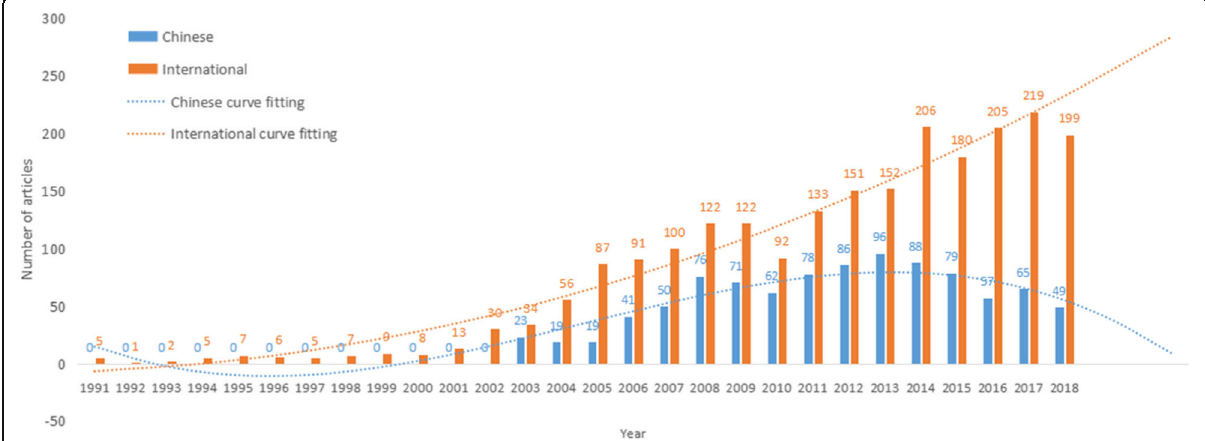
Fig. 2 Temporal distribution and trend of international and Chinese PHEM study